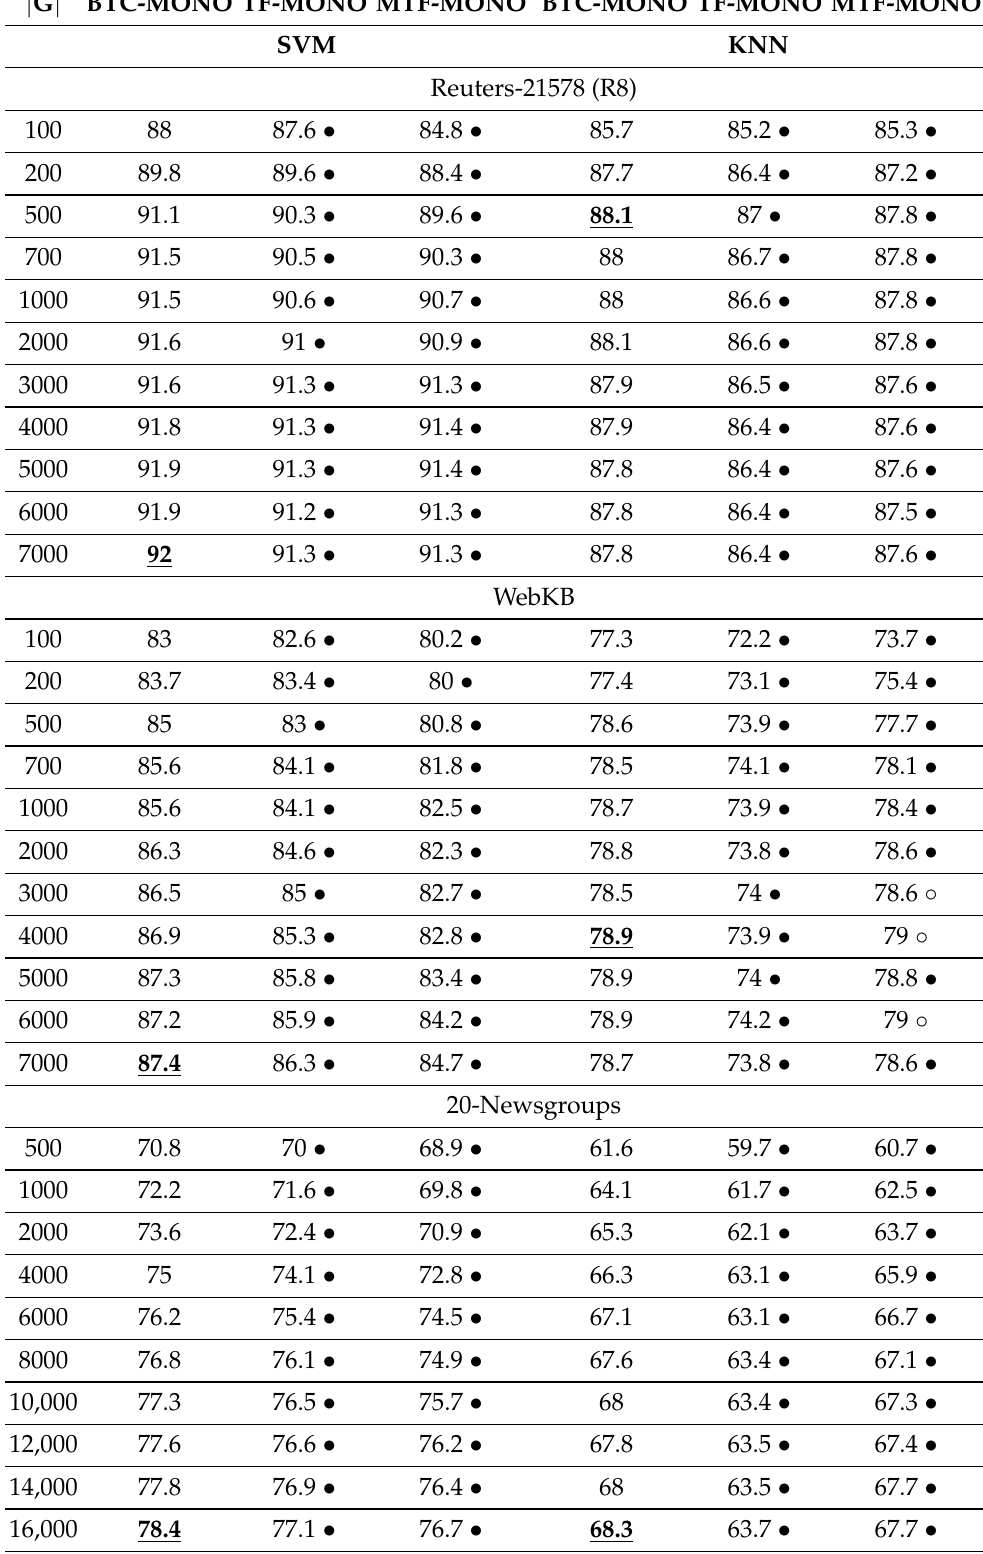
Table 9. Performance comparison of BTC-MONO vs. TF-MONO vs.